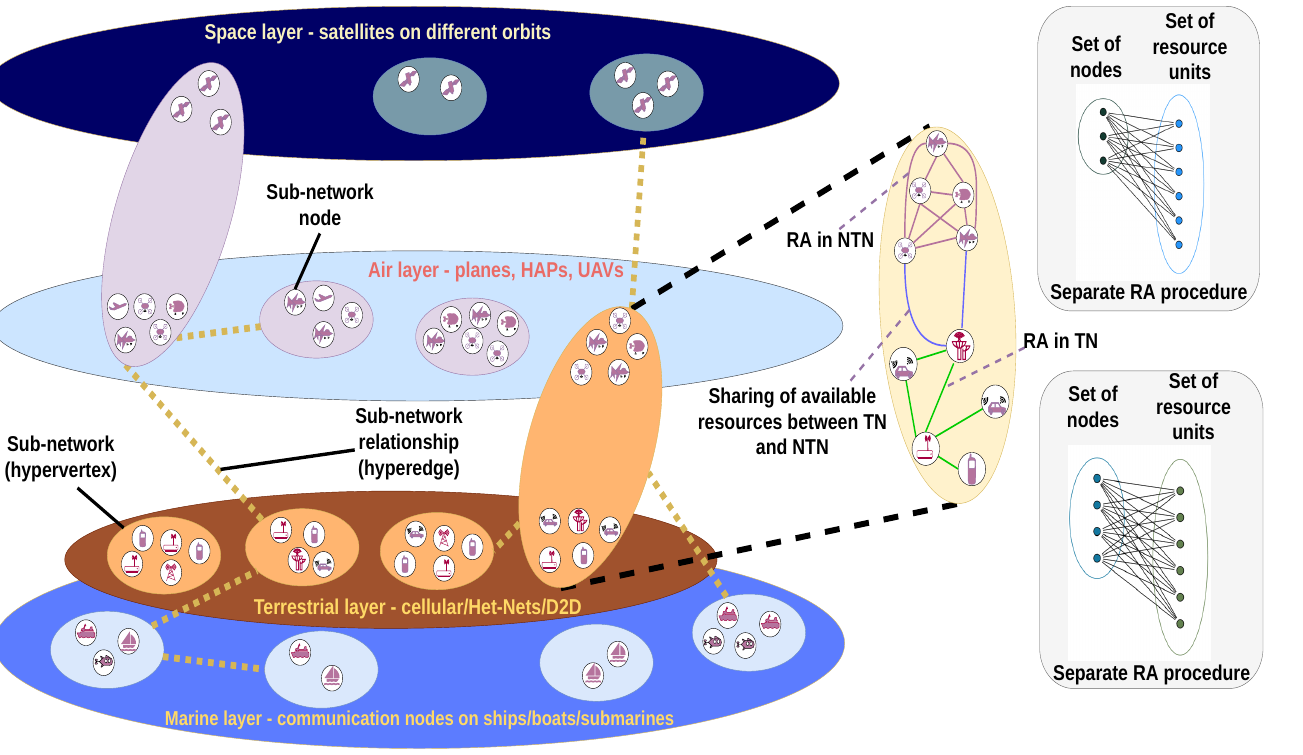
Figure 7. The GRIST